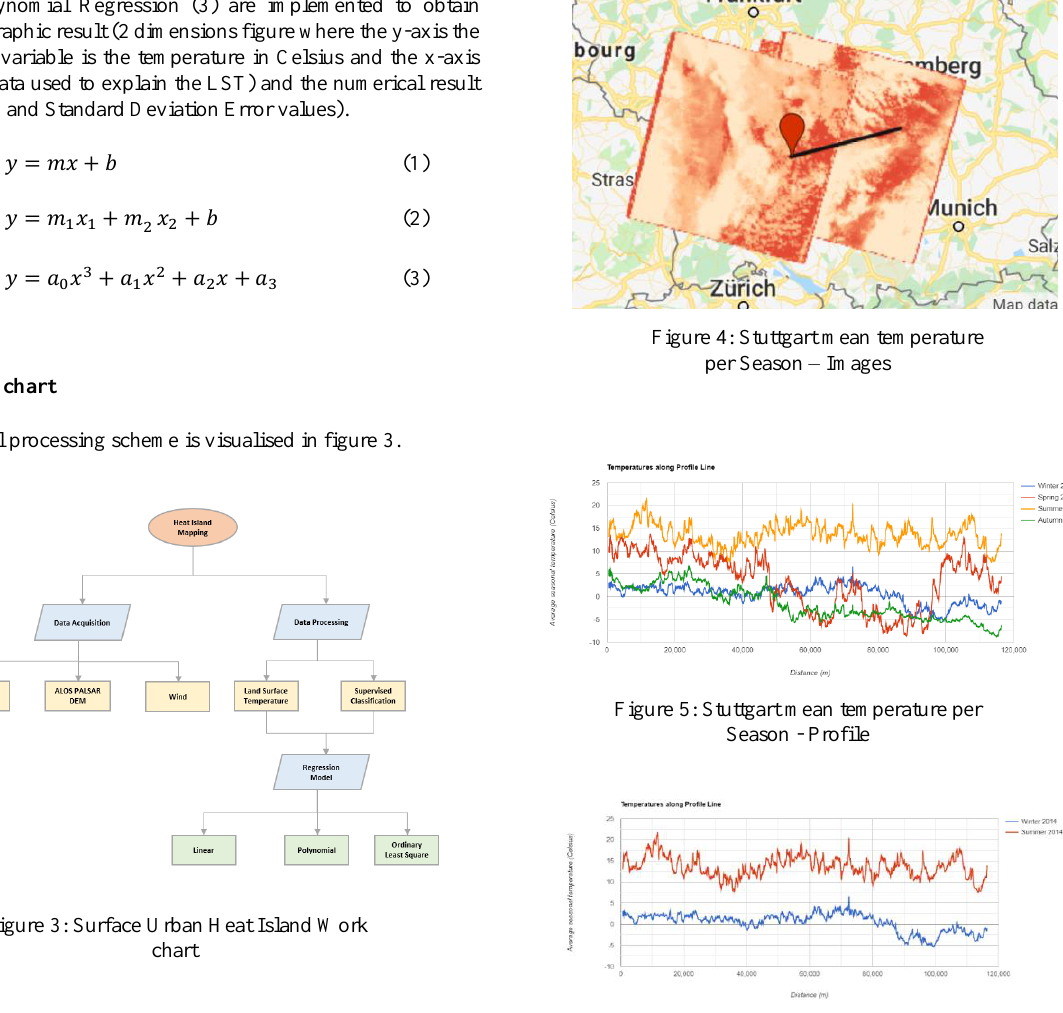
Figure 6: Profile for Winter and Summer